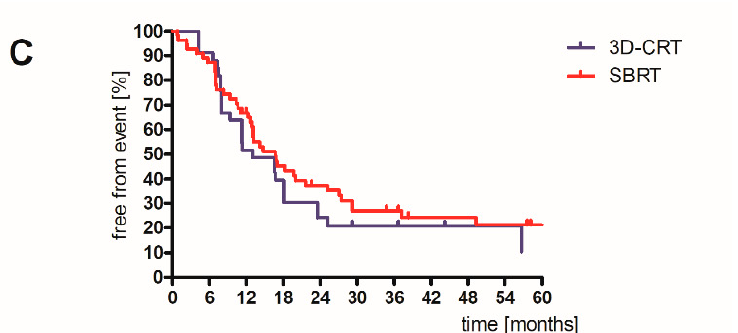
Figure 3. Time to first tumor-related clinical event for entire cohort ( A ), for type of MET ( B ), and for SBRT or 3D-CRT ( C ). Log-rank: type of lesion: p = 0.36; treatment schedule p = 0.45. OSS-MET: osseous metastasis, LN-MET: lymph node metastasis, 3D-CRT: 3D-conformal radiotherapy, SBRT: stereotactic body irradiation.